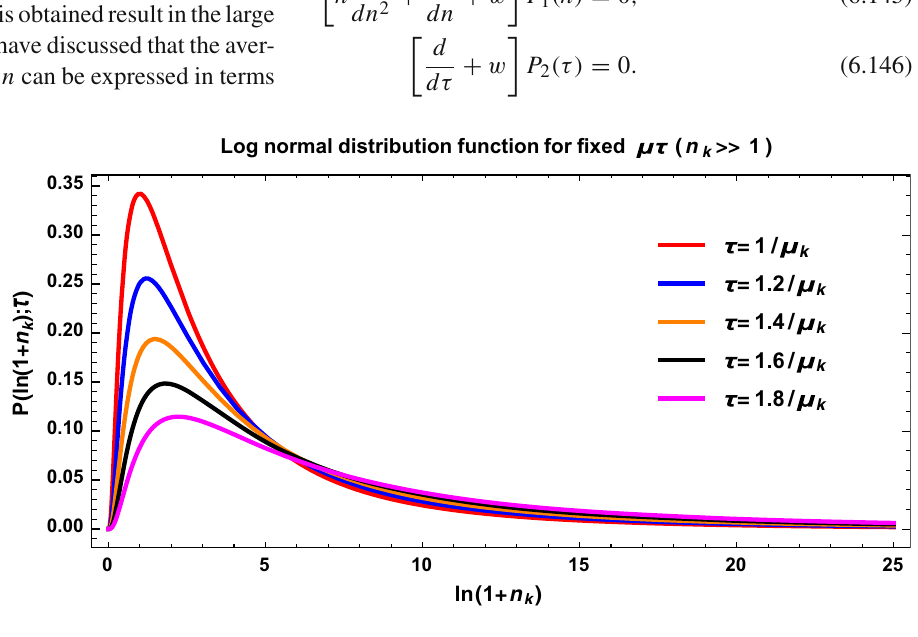
Fig. 36 Evolution of the log normal probability density function with respect to the logarithm of the occupation number per mode ln ( 1 + n k ) , for a fixed time for n k (cid:6)